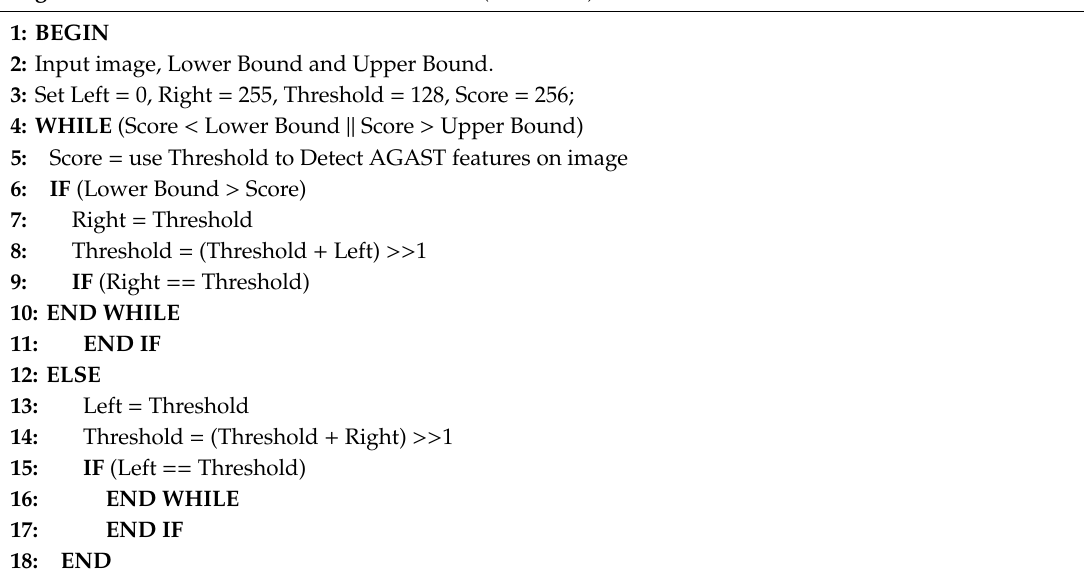
Figure 3. Sixteen pixels 𝐼(𝑥) to examine whether 𝐼(𝑝) is the feature point or not. Algorithm 1 Pseudo code —Multiscale AGAST (MAGAST) (3)